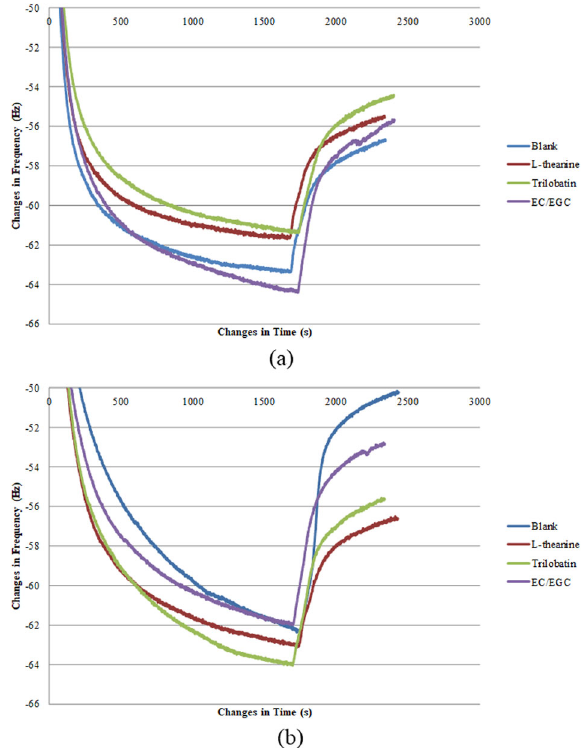
Fig. 4 Representative curves for the frequency change over time for the 3rd overtone generated by the adsorption of saliva- sample mixture onto the gold sensor. a , b Sensitive group and non-sensitive group,